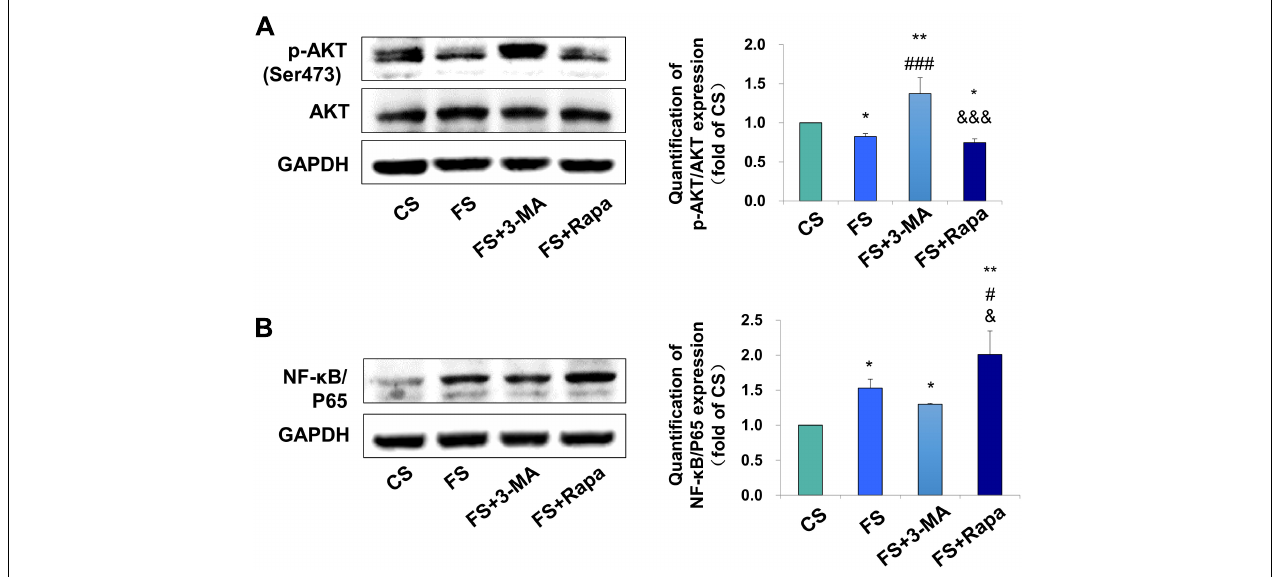
FIGURE 4 | Autophagy in PDLSCs under force stimuli suppressed AKT signaling in THP-1-derived macrophages. (A) Western blot of the expressions of phosphor-AKT (Ser473) and AKT in THP-1-derived macrophages. GAPDH served as an internal control. The relative fold change of p-AKT/AKT was quantified. Activation of autophagy could reduce active AKT activity in FS and FS + Rapa groups, while 3-MA (FS + 3-MA) reversed these effects. (B) Western blot of the expressions of NF- κ B/P65 in THP-1-derived macrophages. GAPDH served as an internal control. The expression of NF- κ B/P65 increased after force loading, which further enhanced after rapamycin application. The relative fold change was quantified. Results are presented as mean ± SD. n = 3. * P < 0.05, ** P < 0.01 versus CS; # P < 0.05, ### P < 0.001 versus FS; & P < 0.05, &&& P < 0.001 versus FS + 3-MA.